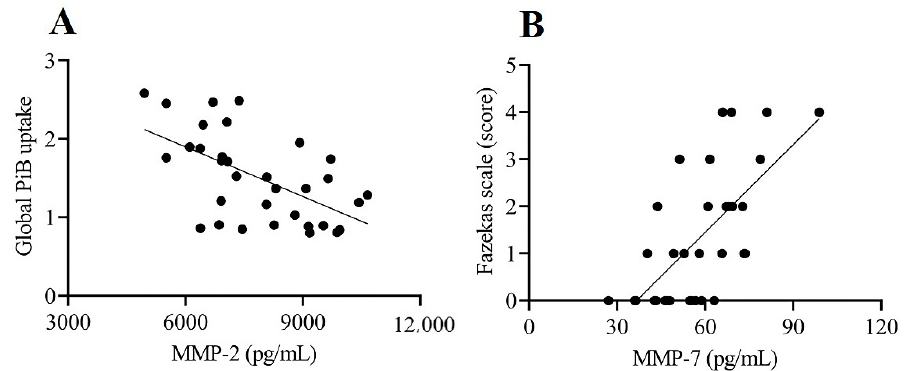
Figure 4. Relationship between CSF levels of MMPs and PiB uptake and Fazekas scale score. ( A ) MMP-2 CSF levels are negatively correlated with global PiB uptake ( β = − 0.414; 95% confidence interval, − 0.796 to − 0.032, p = 0.035). ( B ) MMP-7 CSF levels are positively correlated with Fazekas scale score ( β = 0.419; 95% CI, 0.036 to 0.802, p = 0.033).